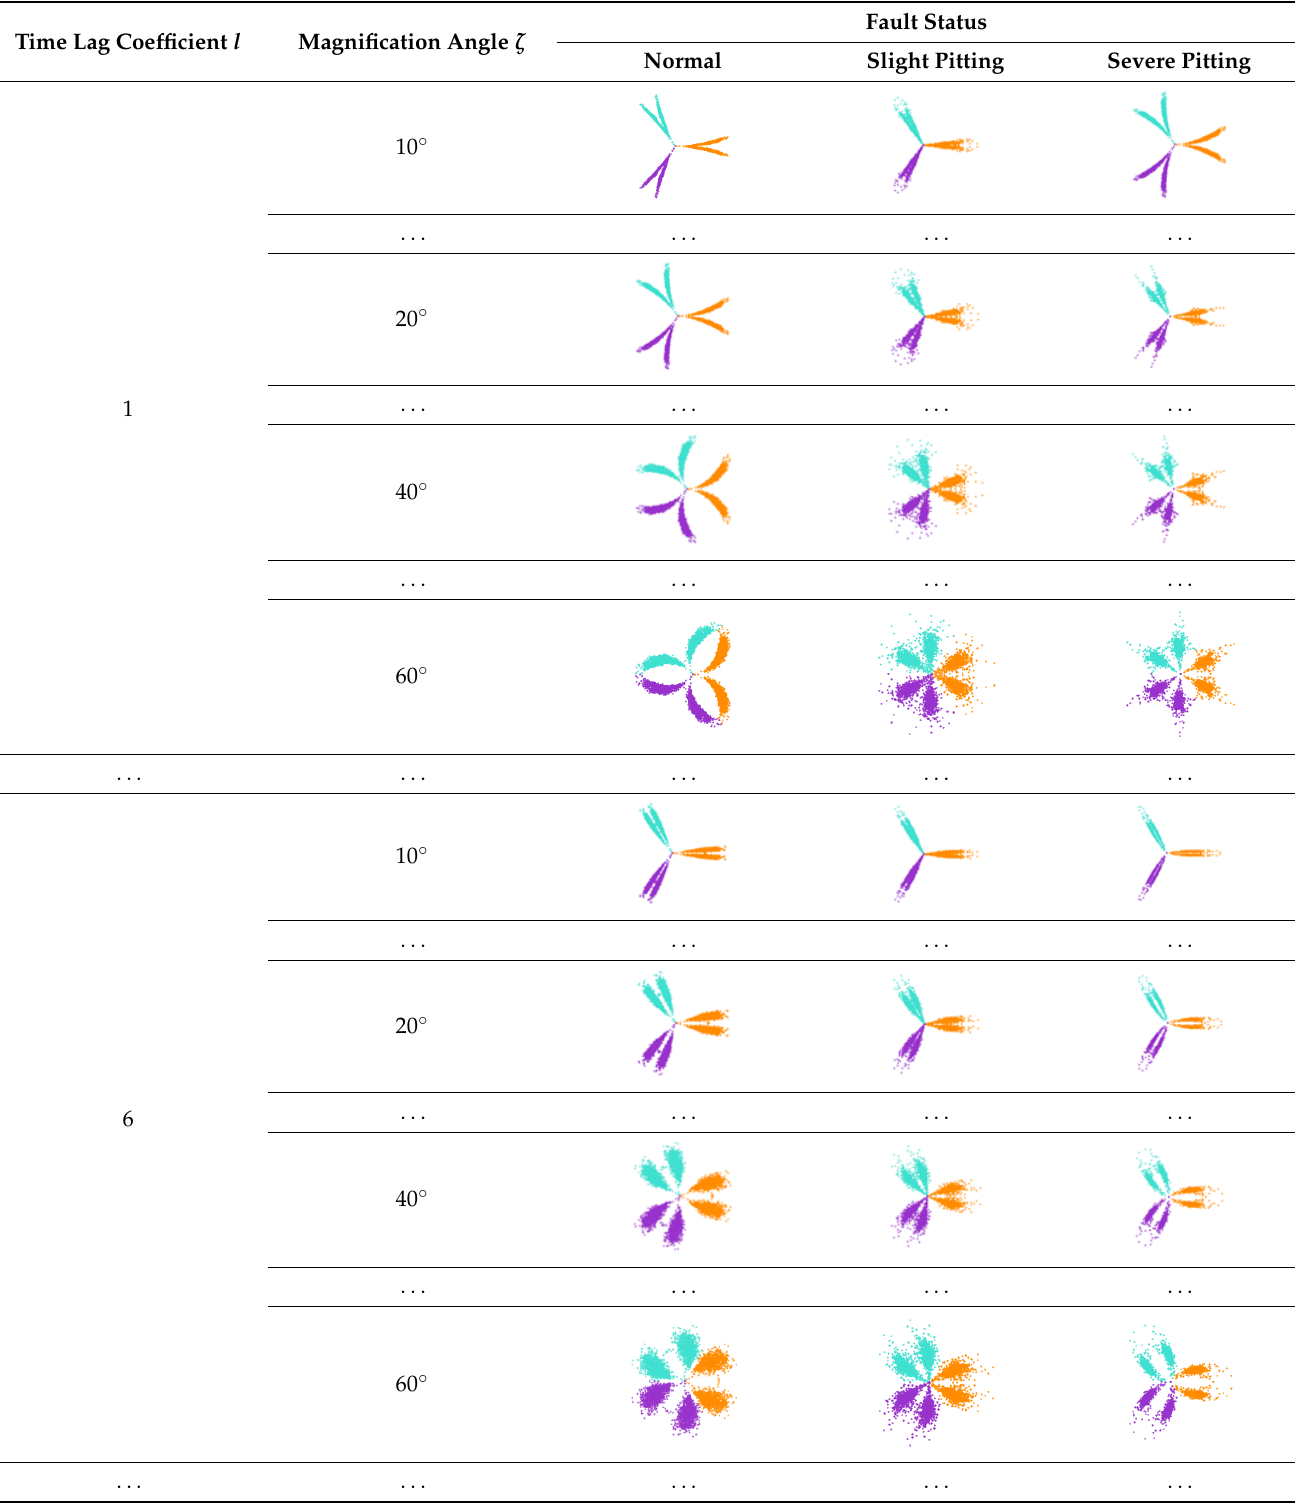
 l  l  l    l l l and . and . Table 2. SDP graph for different states of the bearing with different values of and . Table 2. SDP graph for different states of the bearing with different values of    l l l and . Table 2. SDP graph for different states of the bearing with different values of and . Table 2. SDP graph for different states of the bearing with different values of and .   l l  l and . and . and .   l l  l    l l and . Table 2. SDP graph for different states of the bearing with different values of and . Table 2. SDP graph for different states of the bearing with different values of and . and . and . Table 2. SDP graph for different states of the bearing with different values of l and and . Table 2. SDP graph for different states of the bearing with different values of . Table 2. SDP graph for different states of the bearing with different values of and and . Table 2. SDP graph for different states of the bearing with different values of